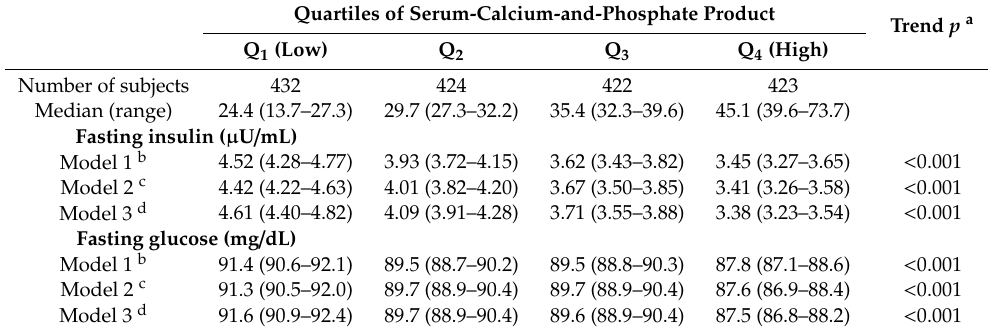
Table 4. Adjusted means (95% CI) of insulin, glucose, HOMA-IR, HOMA- β , and HbA1c across quartiles of serum-calcium-and-phosphate